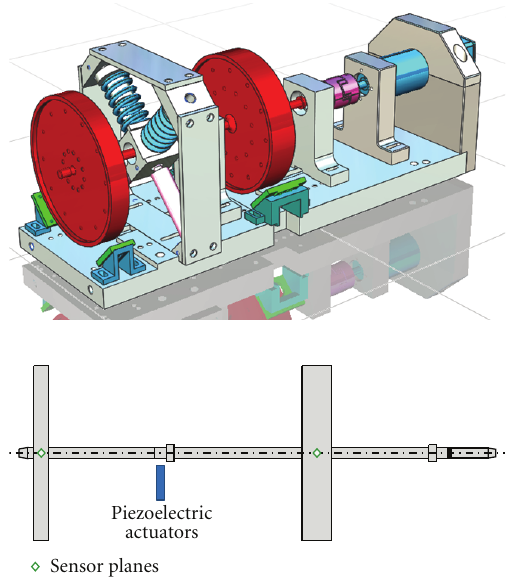
Figure 1: Configuration of the rotor test rig.